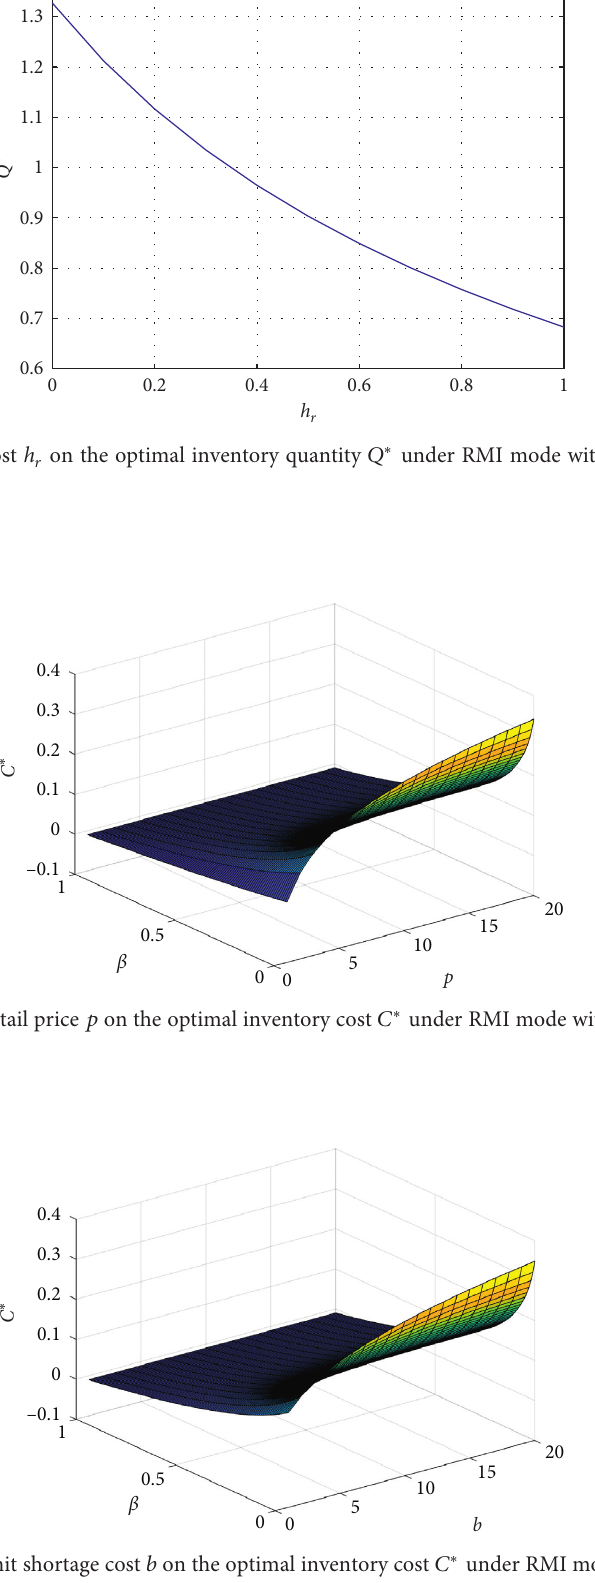
Figure 14: Effect of risk level β and unit shortage cost b on the optimal inventory cost C ∗ under RMI mode with stochastic demand in the water supply